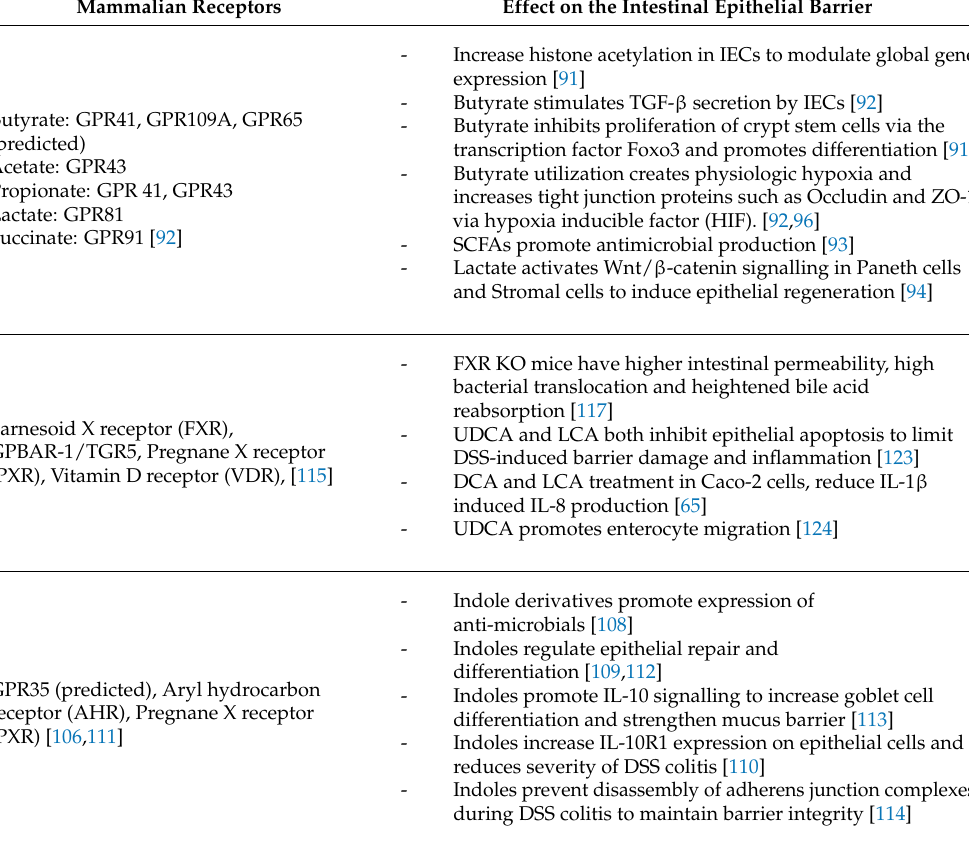
Table 2. Microbial metabolites and their effect on the intestinal epithelial